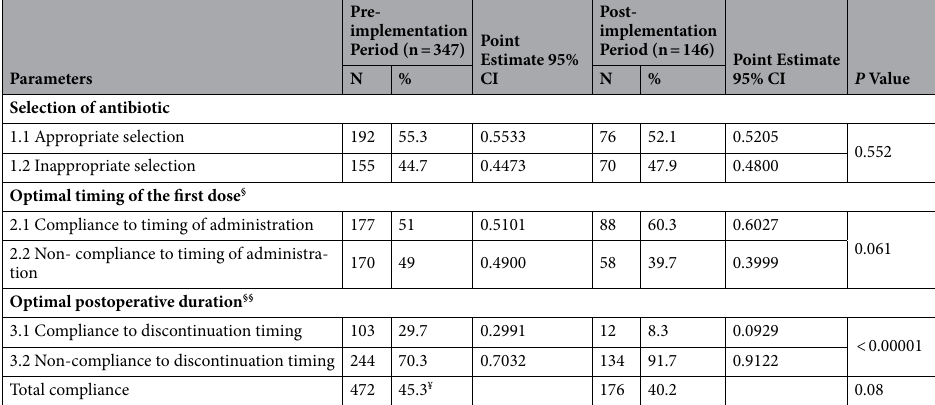
Table 5. Comparison of physicians’ compliance to antimicrobial prophylaxis guidelines pre and post the implementation. § Administration of surgical prophylaxis medications within 1 h before incision or within 2 h for ciprofloxacin & vancomycin. §§ Discontinuation of surgical prophylaxis within 24 h after surgery. ¥ Fisher’s exact test was used for comparing of data before and after the implementation of guidelines. p < 0.05 was considered statistically